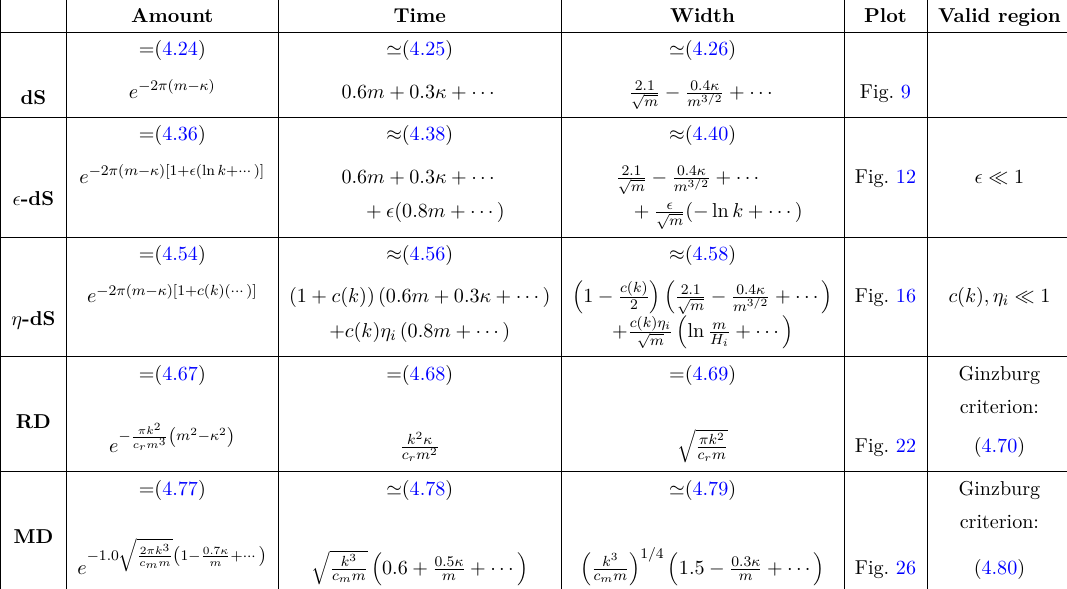
q m 2 and µ = − 1 in H H 2 4